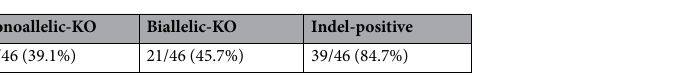
Table 1. C3 targeting in PFFs using the CRISPR/Cas9